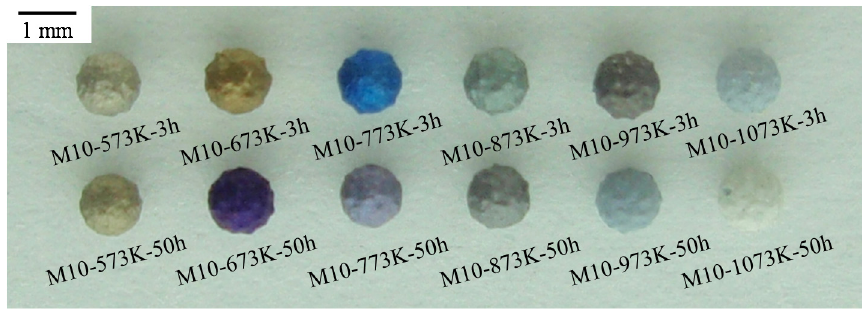
Figure 22. The appearance of the